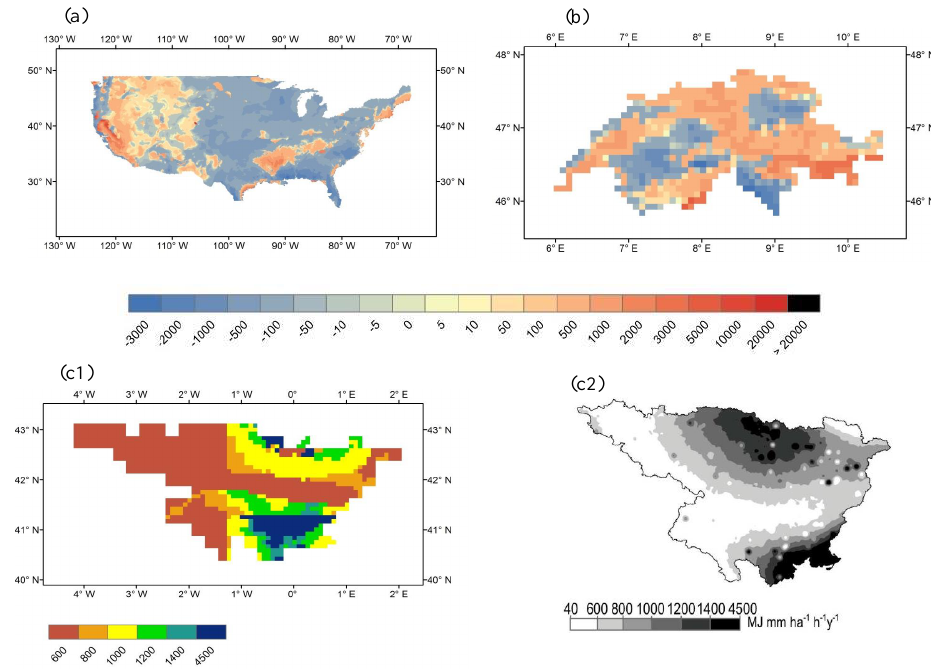
Figure 6. Spatial difference plots showing the difference between the high resolution R values and R values calculated with the new regres- sion equations for (a) the USA, (b) Switzerland and (c) the Ebro Basin in Spain; in panels (a) and (b) the blue colours show an underestimation of the calculated R values when compared to the high resolution R values, while the red colours show an overestimation; the Ebro Basin serves here as an independent validation set and it has two graphs: (c1) a spatial plot of the R factor according to the new regression equations, and (c2) the high resolution R values from Angulo-Martinez et al. (2009) (all values in the graphs are in MJmmha − 1 h − 1 year − 1